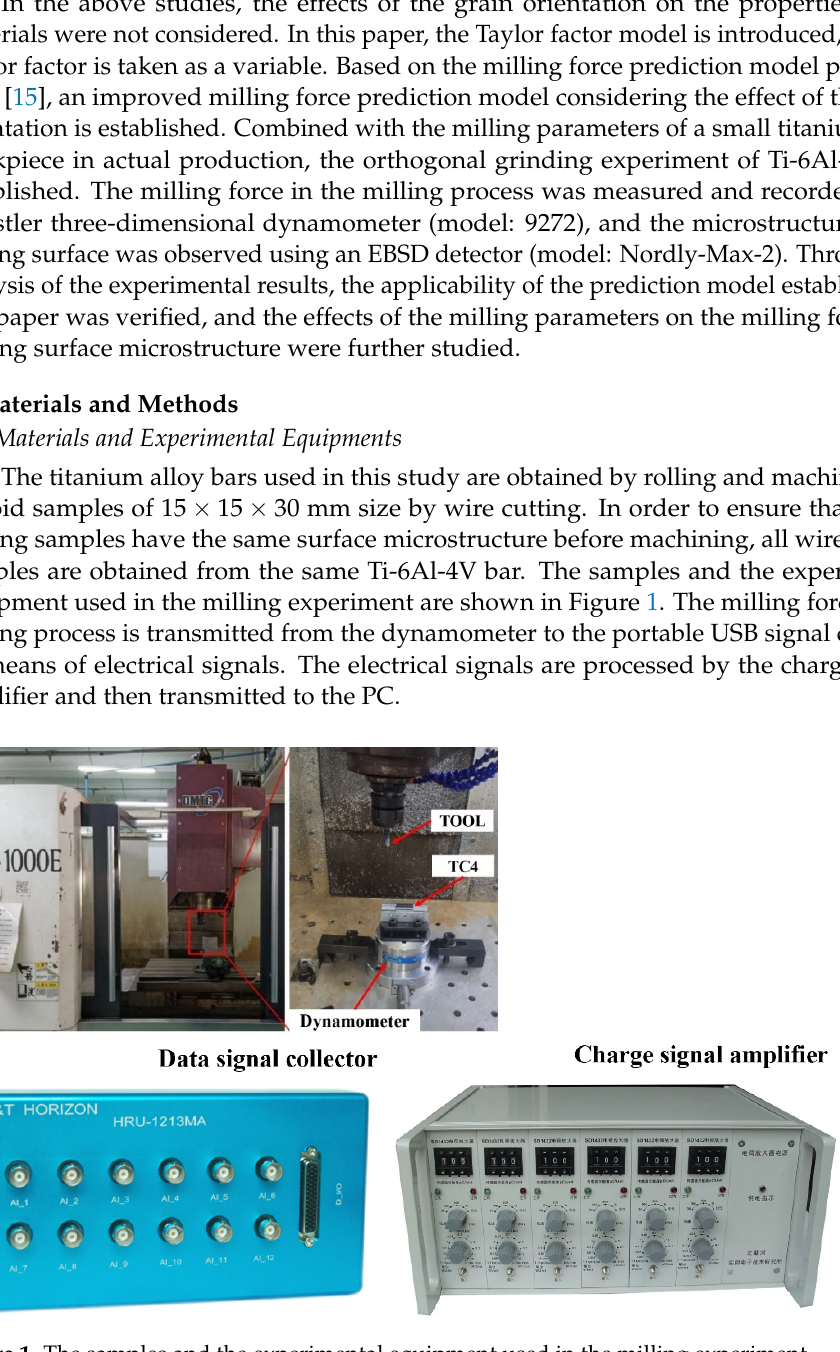
0.3 Figure 2. Schematic representation of the EBSD of single crystal planes. 2.2. Prediction Model of the Milling Force 2.2.1. Taylor Factor Model Schmidt’s law is widely used to study the slip and twin mechanisms of materials. Schmidt’s law holds that there is a critical value of the shear stress in the slip system and twin system, and the slip system and twin system that reach the critical value start first. The Schmidt factor is calculated by the following formula: 𝑆𝑐ℎ𝑚𝑖𝑑𝑡 𝑓𝑎𝑐𝑡𝑜𝑟 = 𝑐𝑜𝑠 (𝛷) ∙ 𝑐𝑜𝑠 (𝛺) (1)